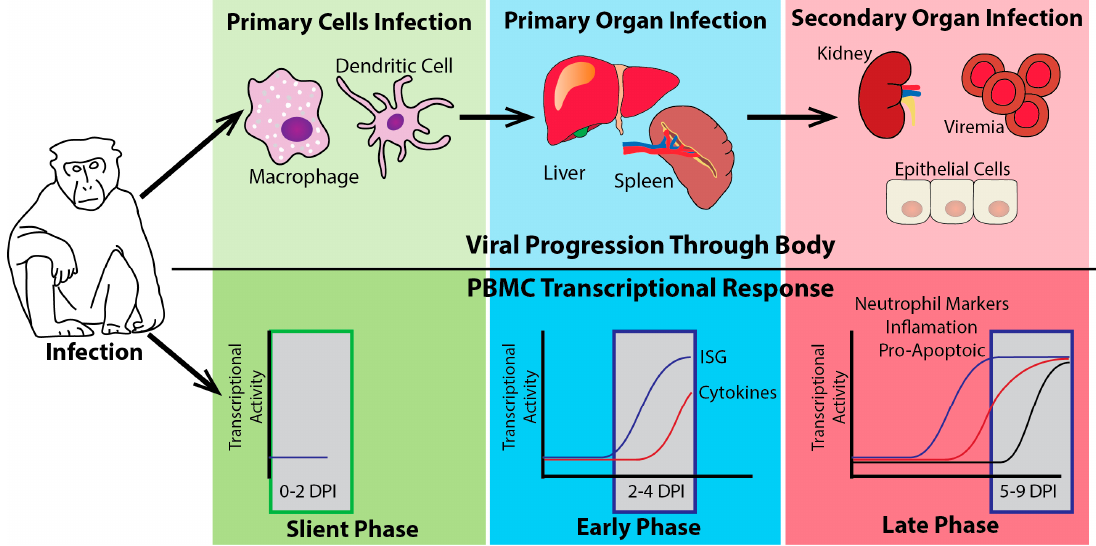
Figure 4. The host transcriptional response to EBOV challenge in NHPs. The illustration shows three distinct stages of transcriptional activation seen in peripheral blood mononuclear cells (PBMCs) following EBOV infection of NHPs. The top half (above the black line) shows the likely viral progression of EBOV from the infection of initial target cells (green phase) to replication in the spleen and liver (blue phase) and finally dissemination into secondary organs (red phase). The bottom panels illustrate the transcriptional activity of different gene families during this progression. The earliest phase of transcriptional activity (0–2 days post-infection (DPI)), in the green box, is the silent phase where very little if any transcriptional activity is present in the PBMCs. During this phase, the virus has initiated infection in primary cell targets. As the virus moves to its primary organs of infection, a robust early phase of transcriptional activity is observed (2–4 DPI). Most notable in this phase is the increase in ISGs. This ISG induction is closely followed by the induction of cytokine genes. Finally, as the virus begins to disseminate through the whole body through the blood (viremia) and begins to infect secondary organ targets, the transcriptional activity enters the late phase characterized by the induction of many pro-inflammatory genes, pro-apoptotic markers, and neutrophil markers in PBMCs.